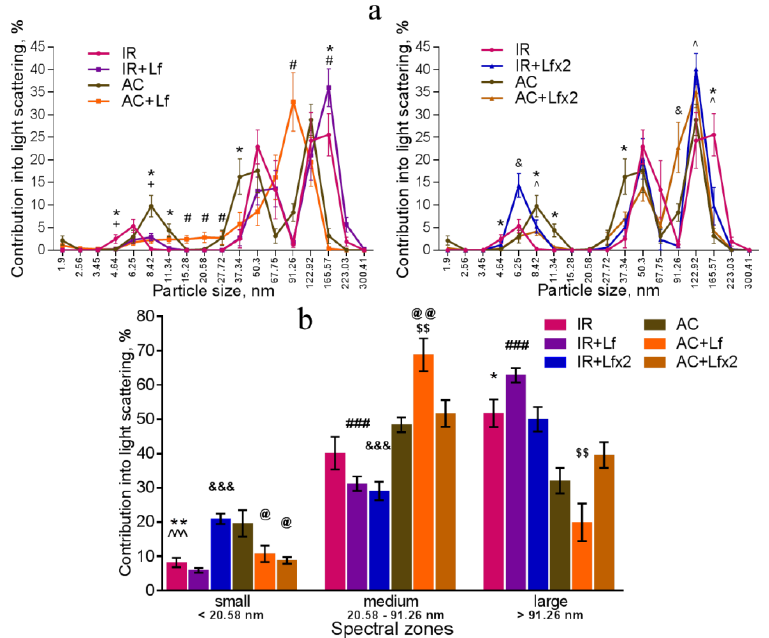
Figure 9. Changes in the DLS spectra of mouse blood serum on day 3 after 7.5 Gy whole-body gamma irradiation. Particle size distribution ( a ). Particles distribution by spectral zones ( b ). n = 5–6 for each group. * p < 0.05, ** p < 0.01—IR vs. AC, # p < 0.05, ### p < 0.001—IR+Lf vs. AC+Lf, & p < 0.05, &&& p < 0.001—IR+Lf×2 vs. AC+Lf×2, + p < 0.05—IR vs. IR+Lf, ^ p < 0.05, ^^^ p < 0.001—IR vs. IR+Lf×2,